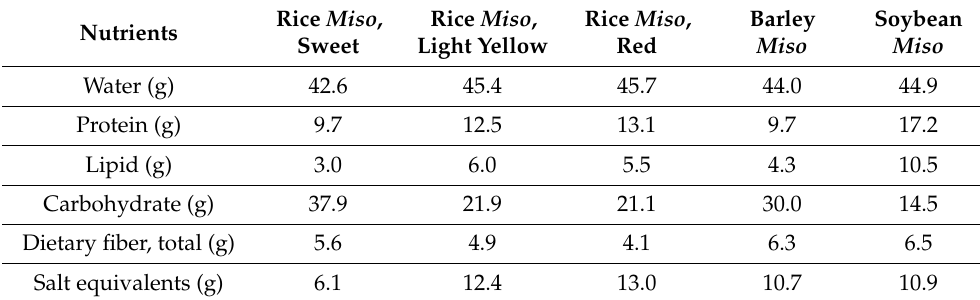
Table 1. Concentration of nutrients in miso (per 100 g) [59].